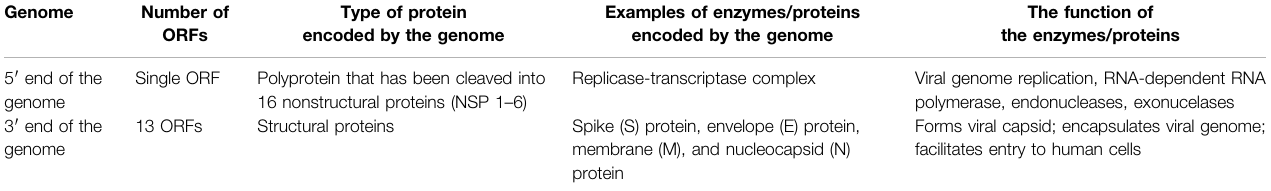
TABLE 1 | SARS-CoV-2 viral genome structure, types of viral proteins, and their function. Genome Number of ORFs